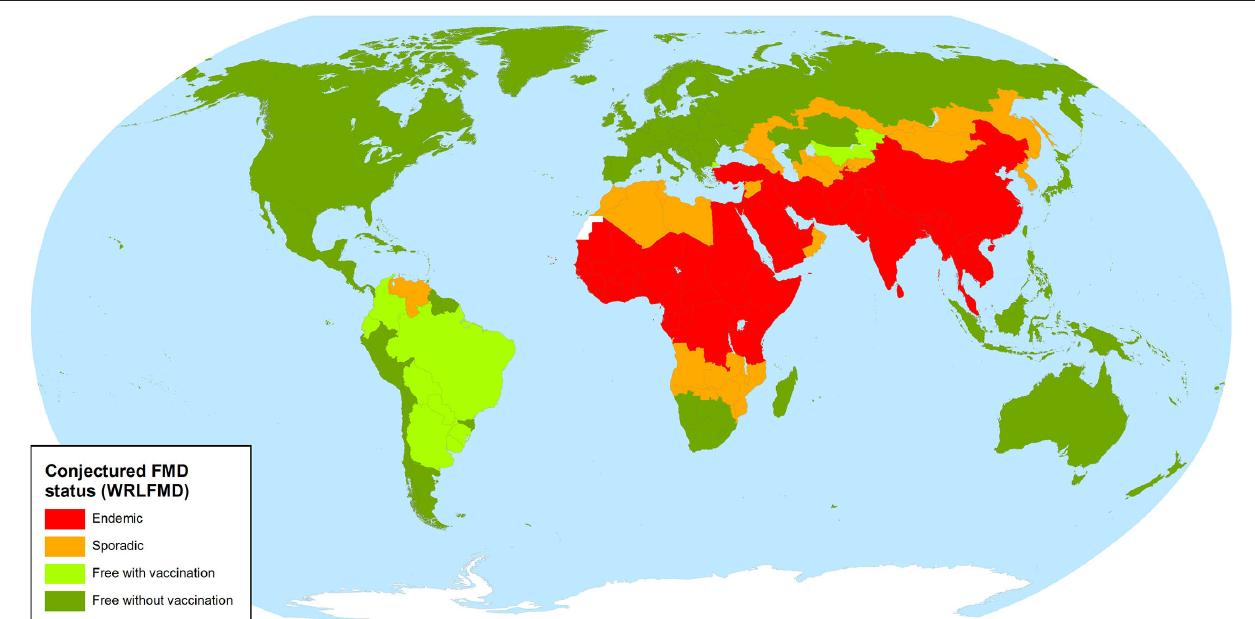
FIGURE 1 | FMD status map of the World Reference Laboratory for FMD